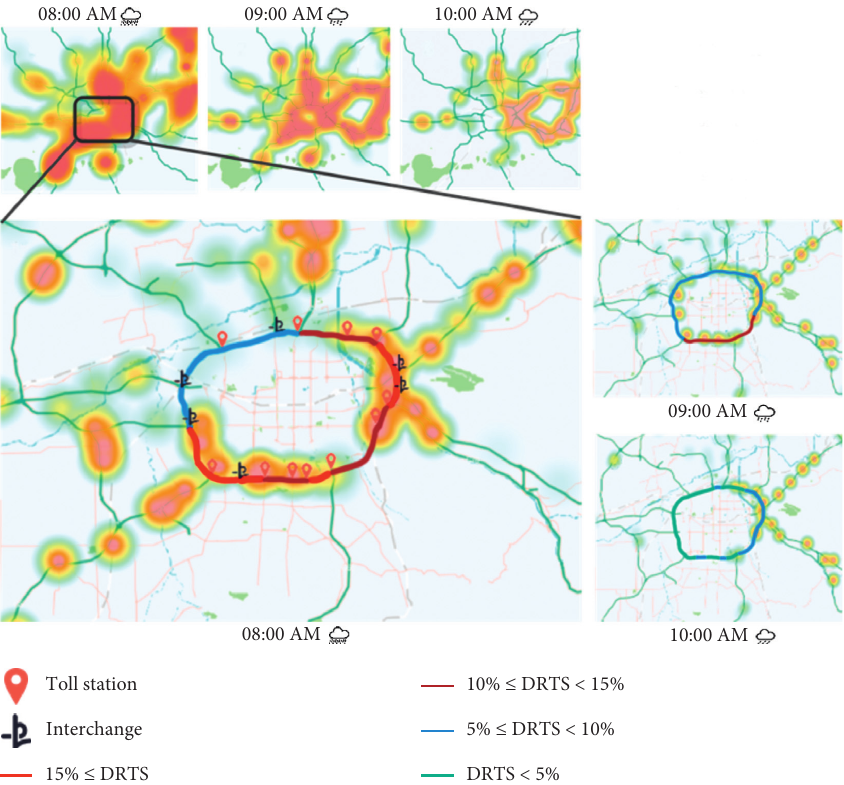
Figure 2: DRTS under different rainfall intensities of Xi’an Ring Road at 8:00 am, 9:00 am, and 10:00 am on June 26,